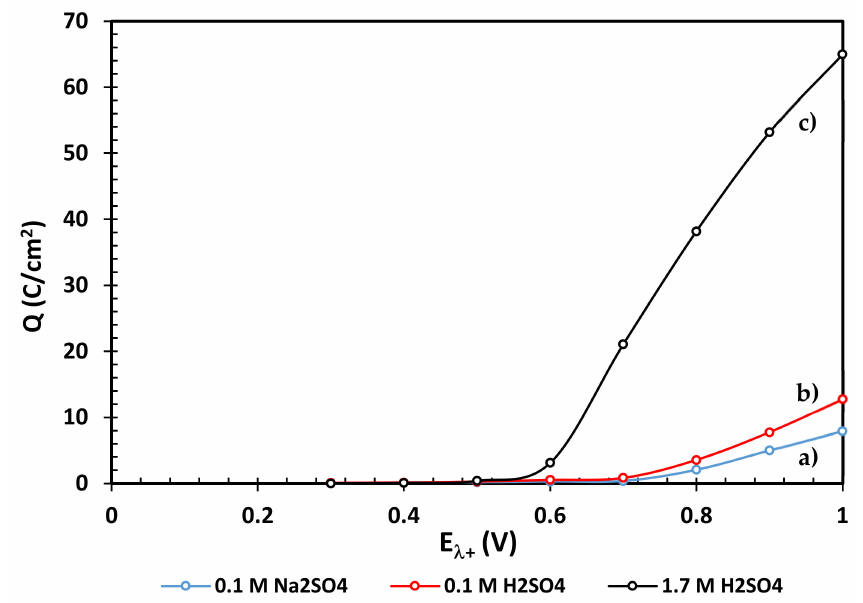
Figure 8. Chronoamperometric charge densities for the zinc concentrate EBHSS using several electrolytic media at different pH values, ( a ) 0.1 M Na 2 SO 4 , pH = 7, ( b ) 0.1 M H 2 SO 4 , pH = 2, ( c ) 1.7 M H 2 SO 4 . Analyses performed without